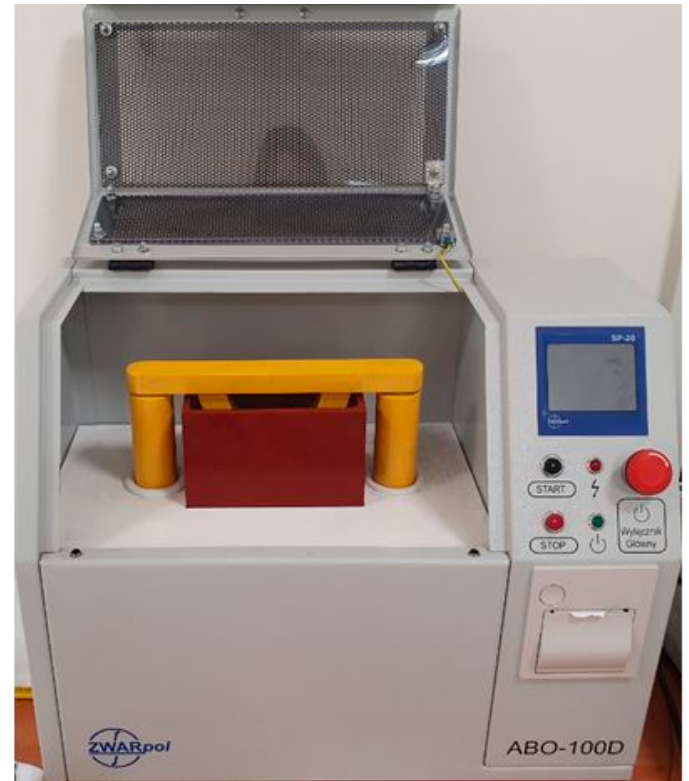
Figure 2. Breakdown voltage tester.